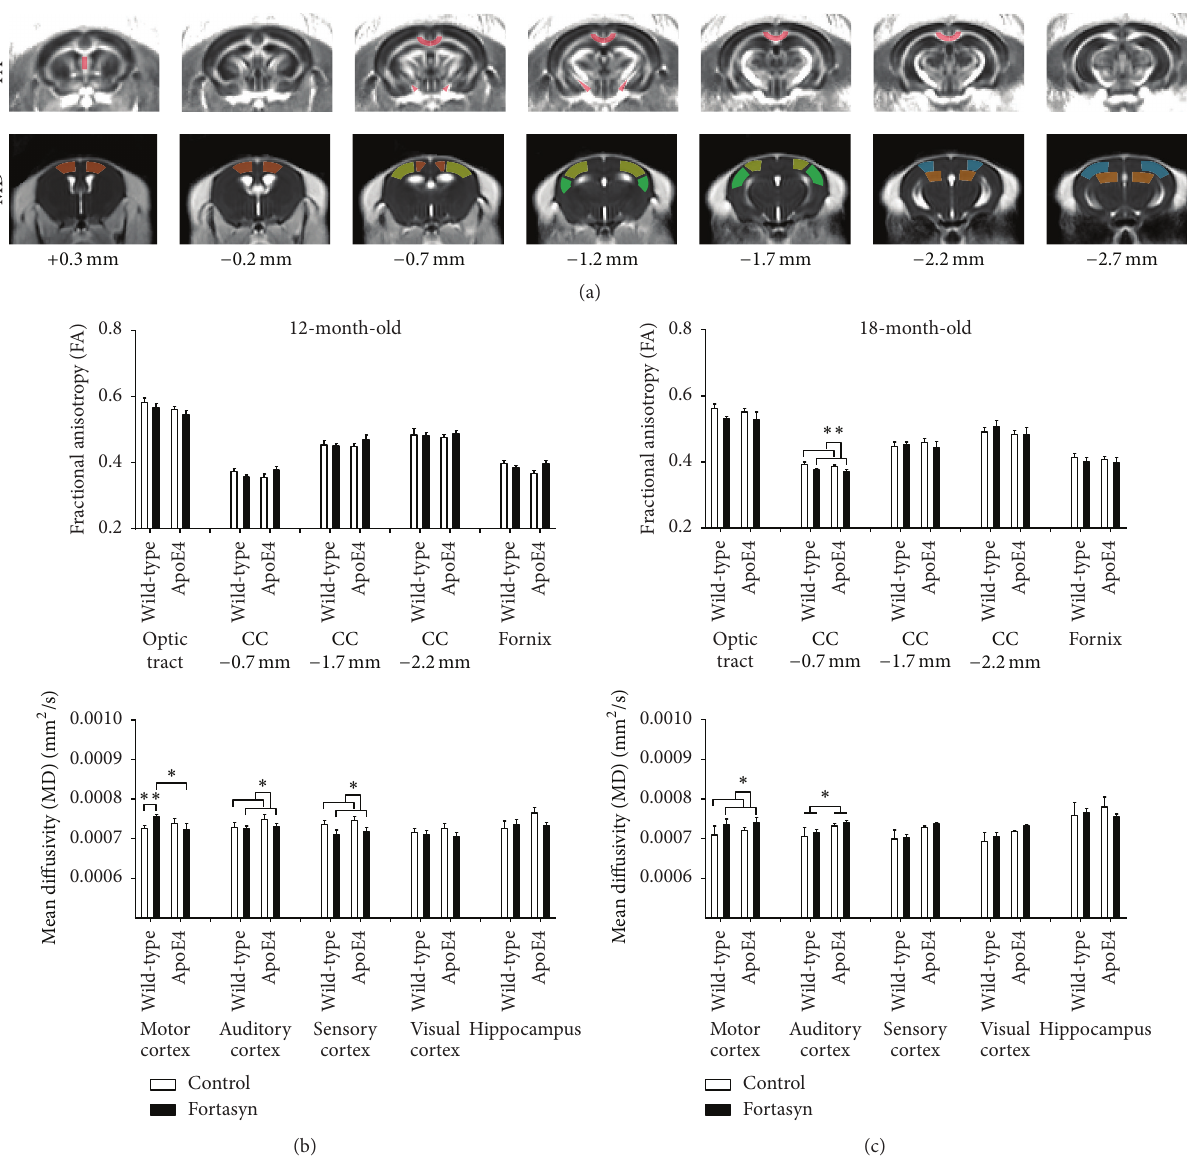
Figure 4: Quantitatively assessed diffusion tensor derived indices at 12 months and 18 months of age in C57BL/6J wild-type control mice and ApoE4 transgenic mice on control diet or Fortasyn diet. (a) Fractional anisotropy (FA) and mean diffusivity (MD) were measured for ROIs drawn in white and gray matter regions, respectively. (b) In 12-month-old mice, no differences in FA were observed. In the 12-month-old mice, the wild-type mice on Fortasyn diet had higher MD in the motor cortex than wild-type mice on control diet ( 𝑝 = 0.009 ). Furthermore apoE4 mice on Fortasyn diet had a lower MD in the motor cortex than wild-type mice on Fortasyn ( 𝑝 = 0.036 ). Fortasyn diet decreased MD in the auditory cortex ( 𝑝 = 0.034 ) and in the somatosensory cortex ( 𝑝 = 0.009 ) compared to control diet, irrespective of genotype. (c) At 18 months of age, Fortasyn fed mice had a lower FA at − 0.7 mm in the corpus callosum than control fed mice ( 𝑝 = 0.008 ). At 18 months of age, apoE4 mice displayed an increased MD in the auditory cortex ( 𝑝 = 0.025 ). ∗ 𝑝 ≤ 0.05 ; ∗∗ 𝑝 ≤ 0.01 ; ∗∗∗ 𝑝 ≤ 0.001